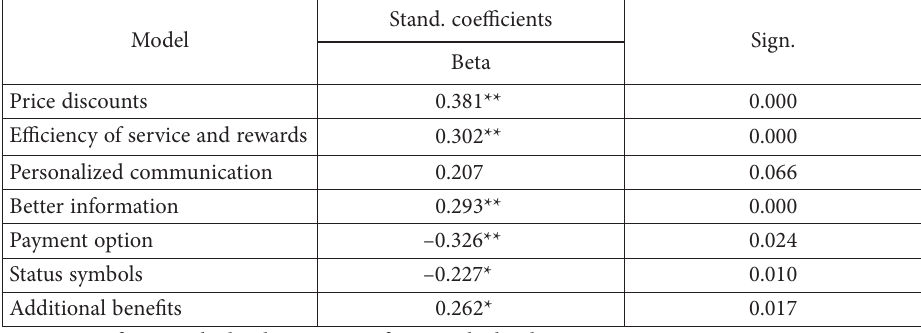
Stand. coefficients